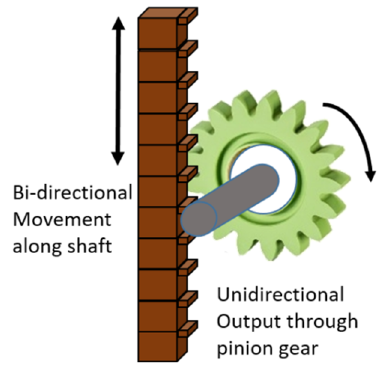
Figure 16. Rack-pinion gear based biomechanical electricity generation used in backpacks for utilizing up and down movements of the center of mass, redrawn from the schematic shown in [315].